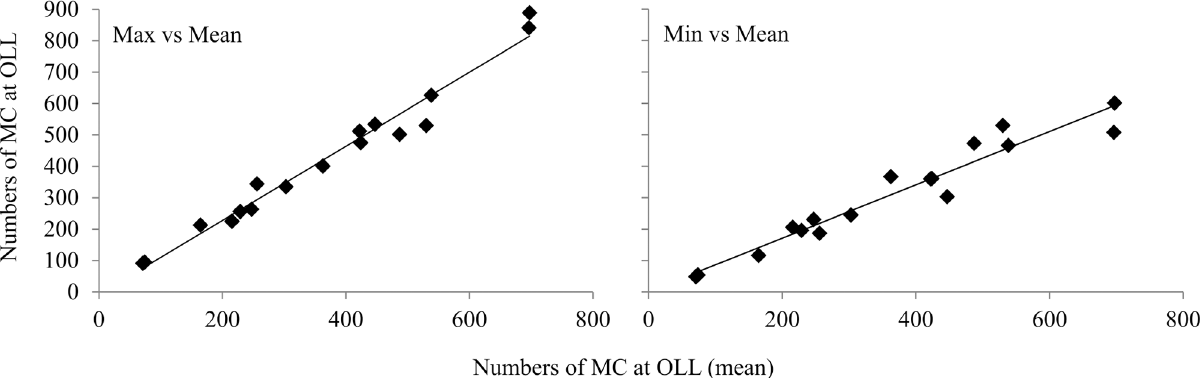
Fig 4. Mean mother-calf pairs counts vs maximum and minimum counts at Ojo de Liebre Lagoon. Mean, maximum and minimum counts of mother- calf pairs (MC) at Ojo de Liebre Lagoon (OLL) during the month of February; Mean: sum of the total number of whales counted during all the surveys conducted during February divided by the total number of surveys conducted in that month (total whales/total surveys); Max: survey with the maximum number of MC pairs counted; Min: survey with the minimum number of MC pairs counted.